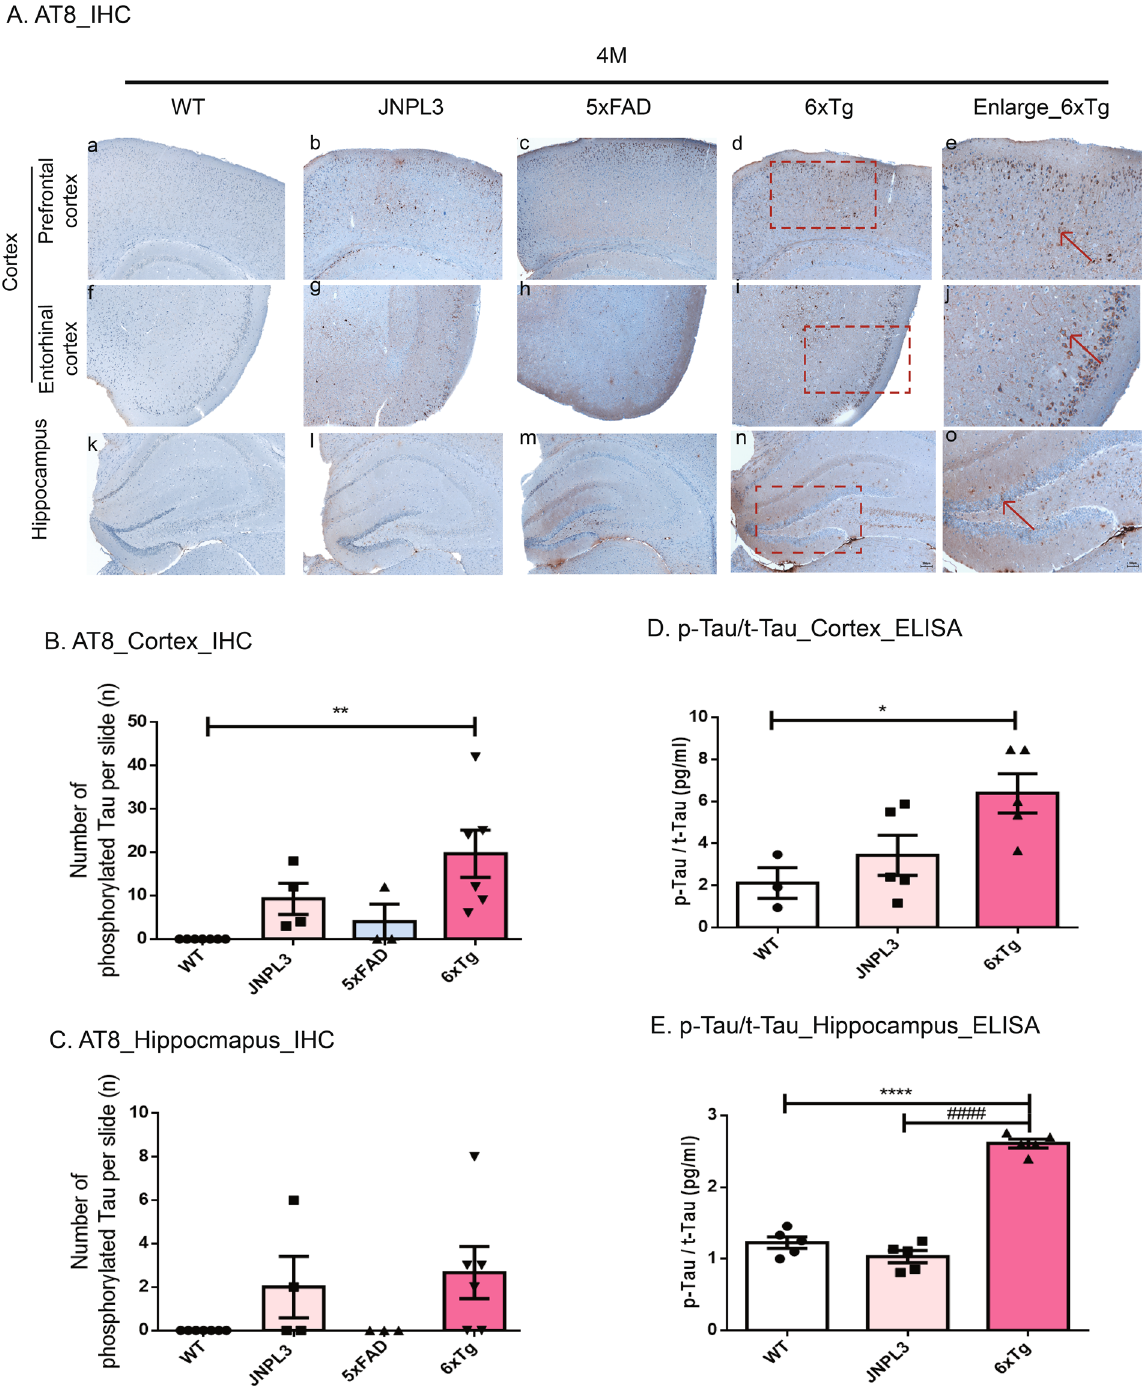
Figure 3. Age-dependent increase of PHF tau deposits and phosphorylated tau amounts in the brains of 6xTg mice. ( A ) Immunohistological staining of tau pathology with anti-phosphorylated Tau (AT8) in the cortex [prefrontal cortex ( A – D ) and entorhinal cortex ( F – I ), CX] and hippocampal dentate gyrus (K–N, HP) of 4-month-old 6xTg mice and their age- and gender-matched WT, JNPL3 or 6xTg littermates. The red box contains enlarged images of the cortical and hippocampal regions of 6xTg mice ( E , J , O ). Red arrow-shaped AT8-positive neurons were counted. ( B , C ) In the 4-month-old mice, PHF tau deposits in the cortex of 6xTg mice showed a significant increase compared with 5xFAD and WT mice, but the number of phosphorylated tau in the hippocampus of 6xTg mice showed no significant difference compared with 5xFAD mice, but showed a tendency to increase. ( D , E ) Phosphorylated tau (p-Tau) and total tau (t-tau) from cortical and hippocampal brain lysates of mice were subjected to ELISA assay and levels of p-Tau/t-tau were examined. All data are given as means ± SEM (n = 3–5 mice per group). Statistical analyses were performed by one-way ANOVA followed by the Tukey’s multiple comparisons test. **** p < 0.0001, *** p < 0.001, ** p < 0.01 vs, * p < 0.05 vs. WT; ## p < 0.01 vs. JNPL3; $$$$ p < 0.0001 vs, $$ p < 0.01 vs.